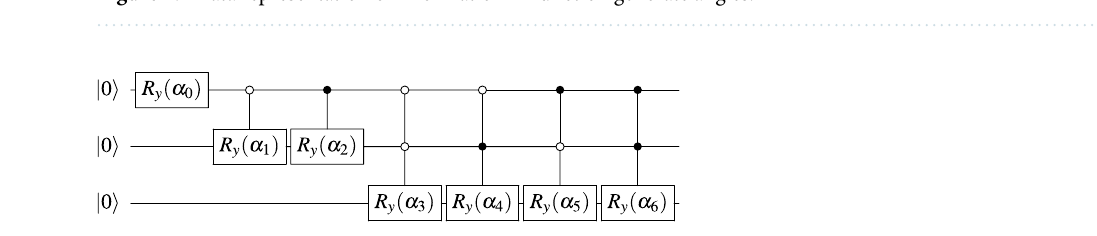
Figure 2. Circuit to load an 8 dimensional real vector in a quantum